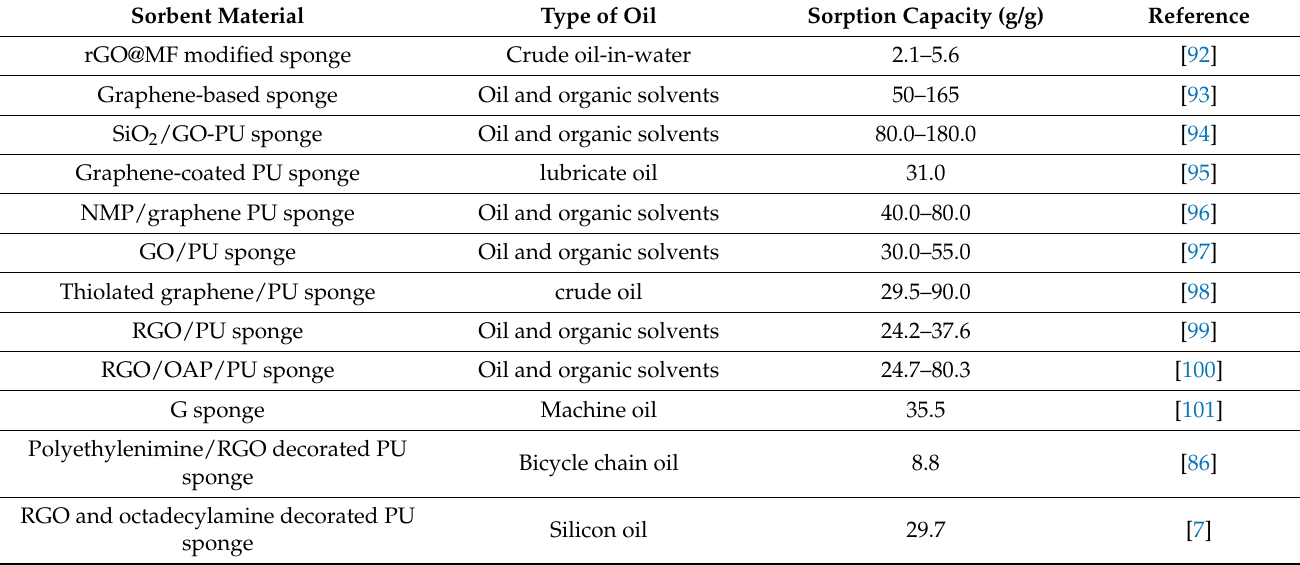
Table 3. Sorption capacities of several graphene-based modified sponges for oil/water